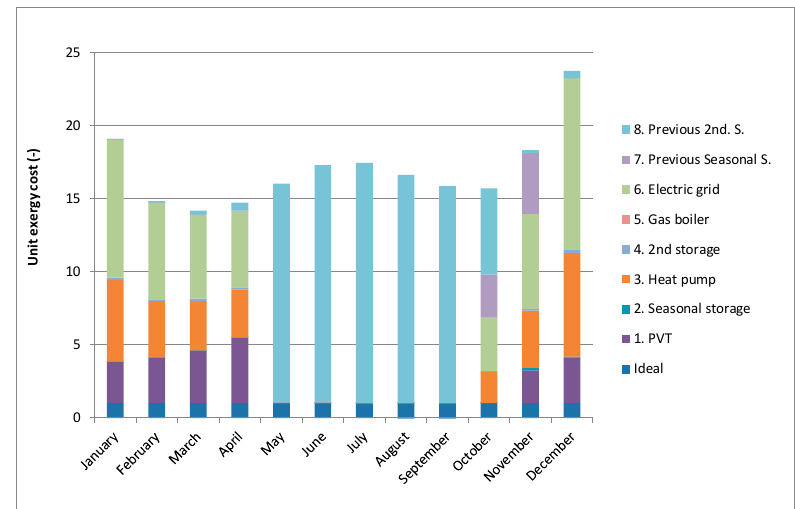
Figure A4. Secondary storage: Cost formation by irreversibility.